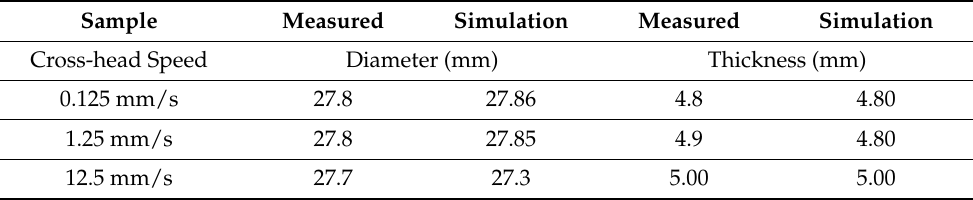
Table 1. Double cone deformed sample size measurements validating simulation geometric